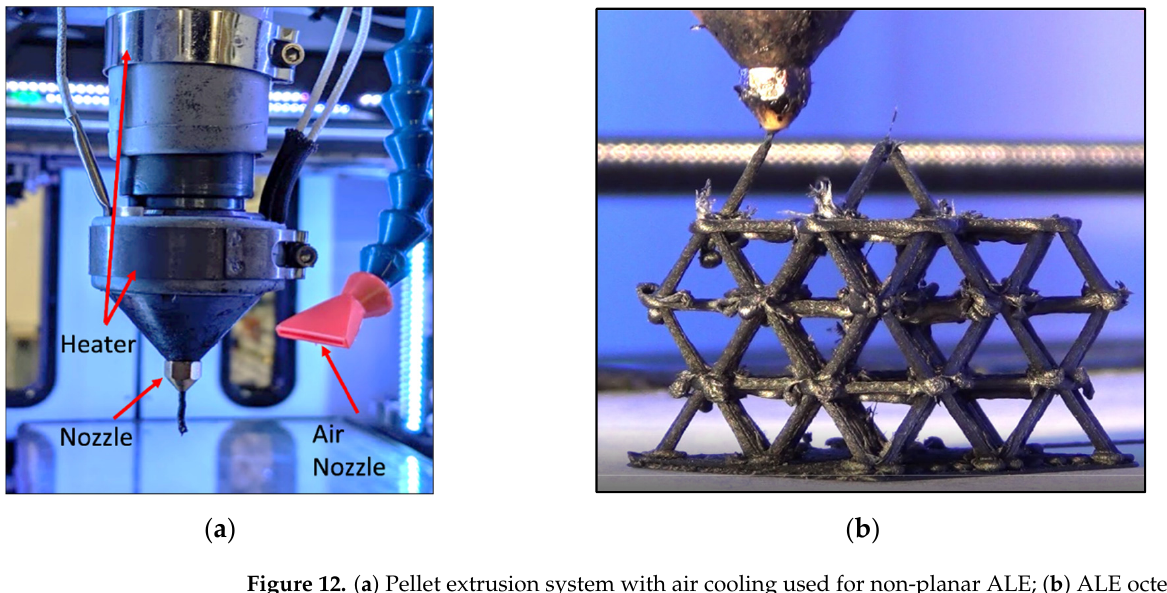
Figure 12. ( a ) Pellet extrusion system with air cooling used for non-planar ALE; ( b ) ALE octet truss structure fabrication.